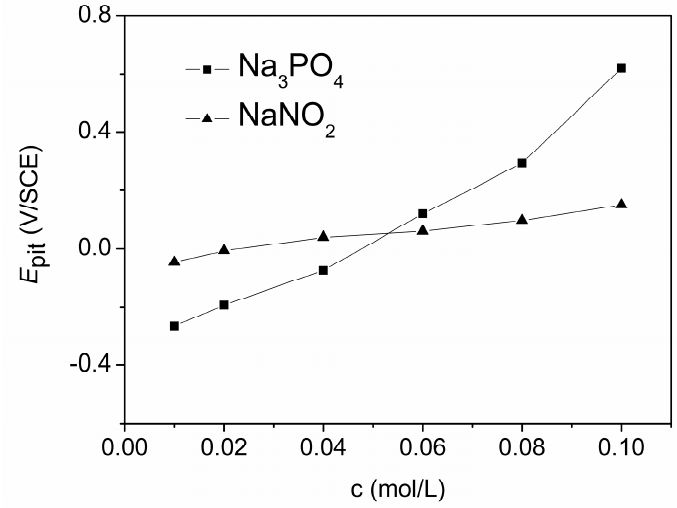
Figure 2. The relationship between the critical pitting potential ( E pit ) and the concentrations of Na 3 PO 4 or NaNO 2 or NaNO 2 (c).